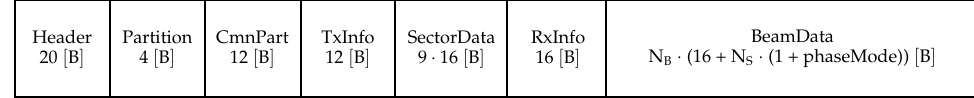
Figure 1. MWC datagram as described by Kongsberg (410224 Revision H). Sizes of data elements not to